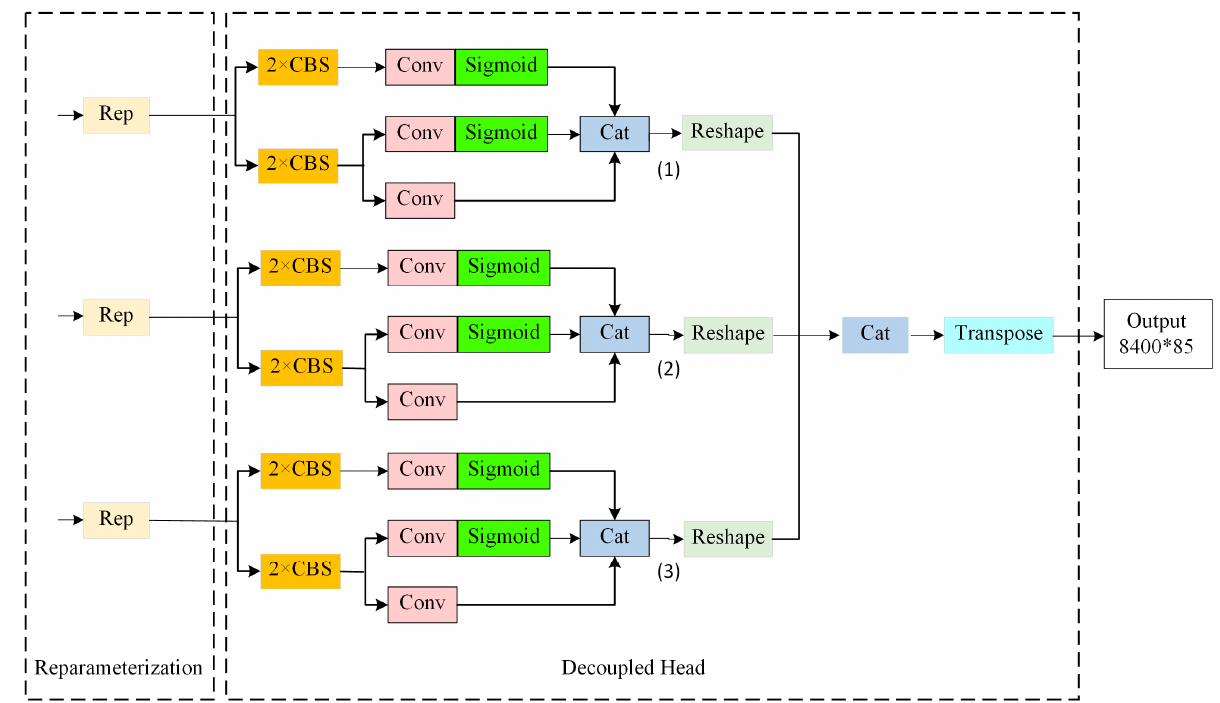
Figure 2. RepHead network